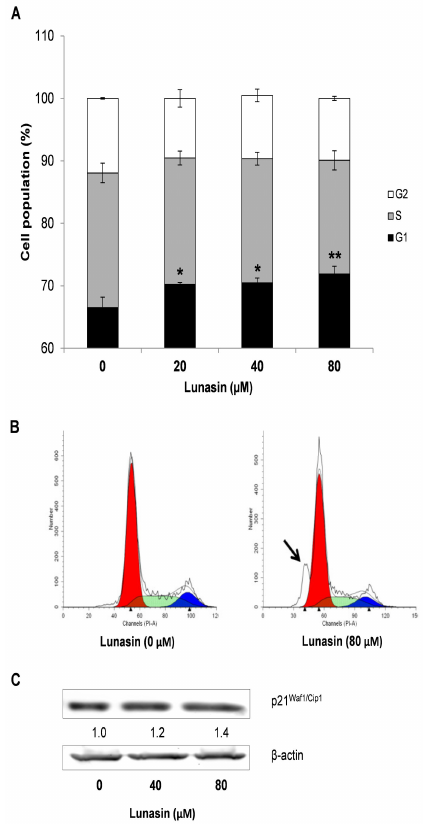
Figure 4. E ff ect of lunasin on cell cycle progression of HCT-116 cells. Cells were treated with lunasin at the indicated concentrations for 72 h, and harvested for cell cycle analysis and Western